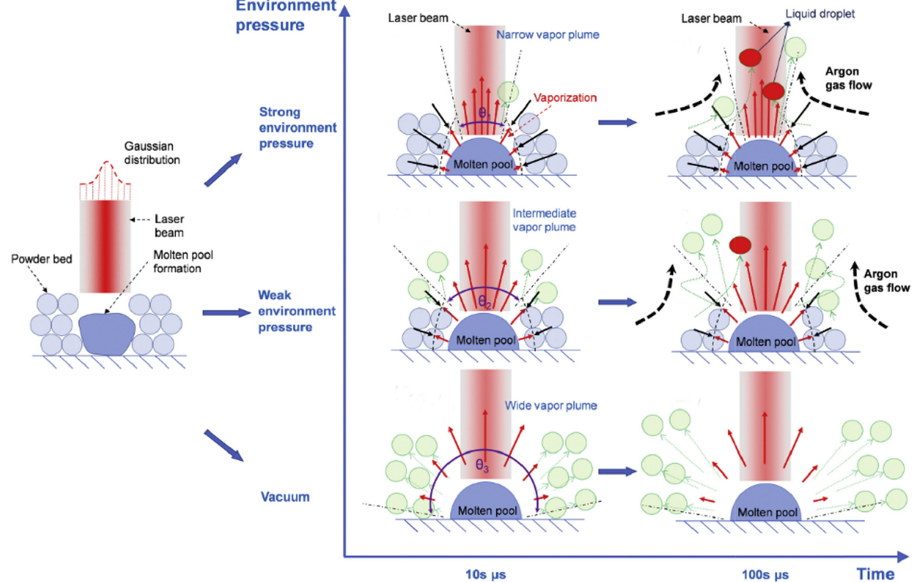
Figure 24. Schematic of powder spattering behavior as a function of time and environment pressure during L-PBF.(Reprinted with permission from Ref. [36]. Copyright 2018 Elsevier B.V.).